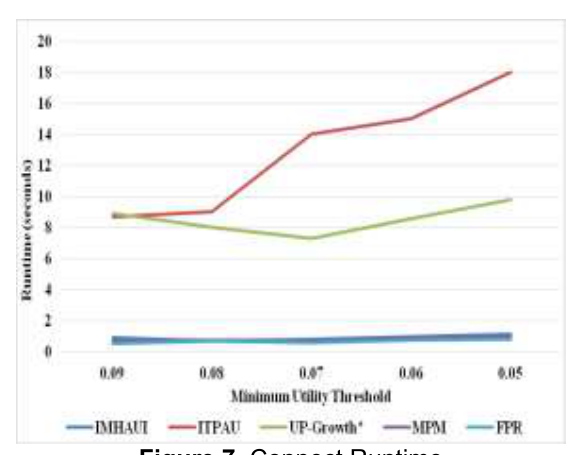
Figure 4. Heart_Cleveland Runtime